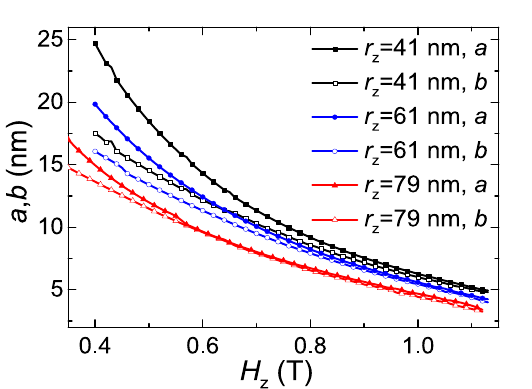
Figure 4. Variation of the skyrmion size with H z for different r z in the nanotube with R = 80 nm and r = 40